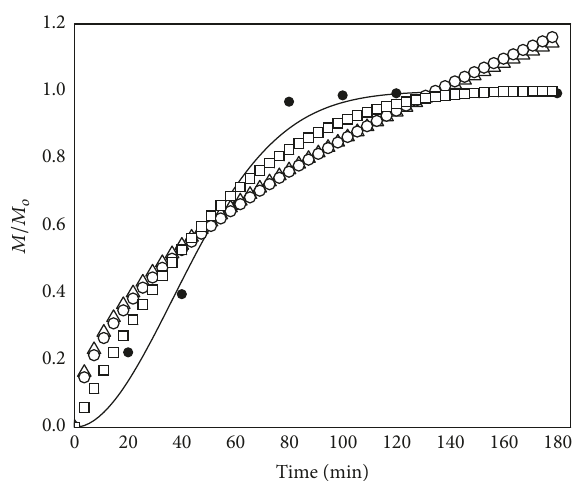
Figure 7: Curve fitting to the release of ibuprofen from nanopar- ticles prepared at F.5/15/1.75 conditions: equations of ( △ ) Higuchi, ( I ) Korsmeyer-Peppas, and ( ◻ ) Hixson; the line represents Weibull equation and ( e ) the experimental data.